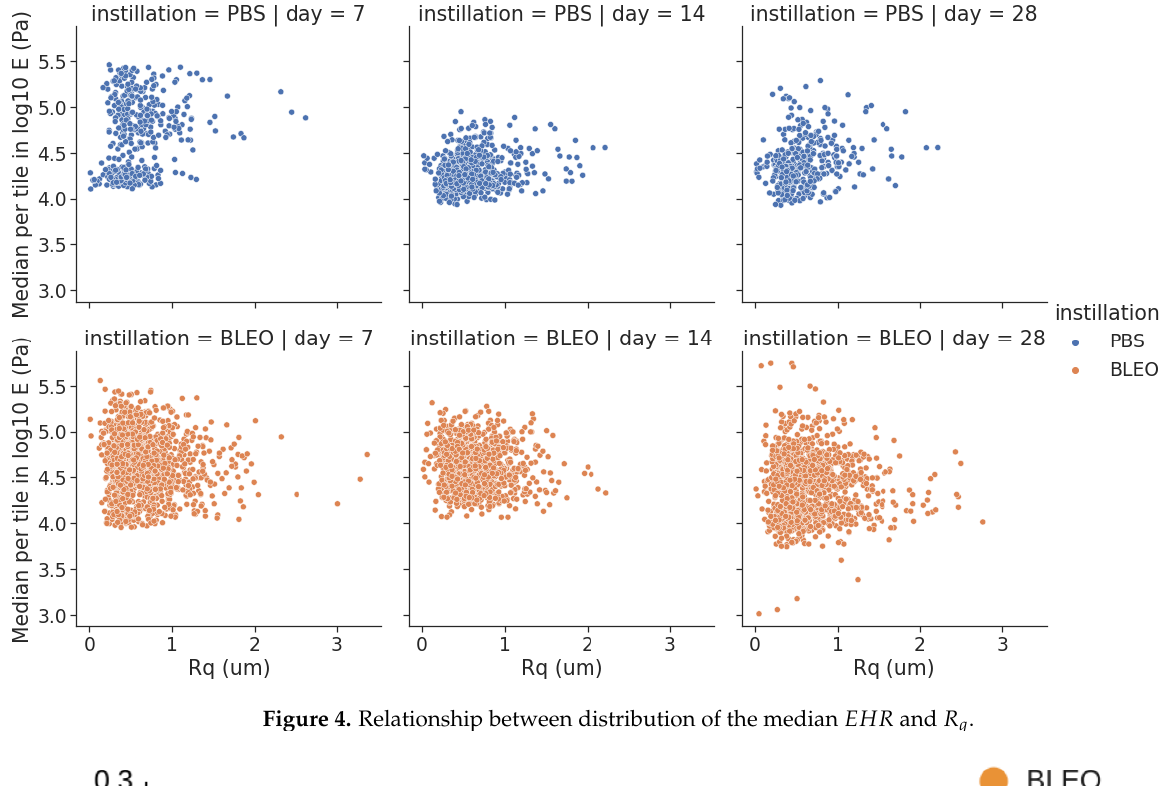
Figure 4. Relationship between distribution of the median EHR and R q .